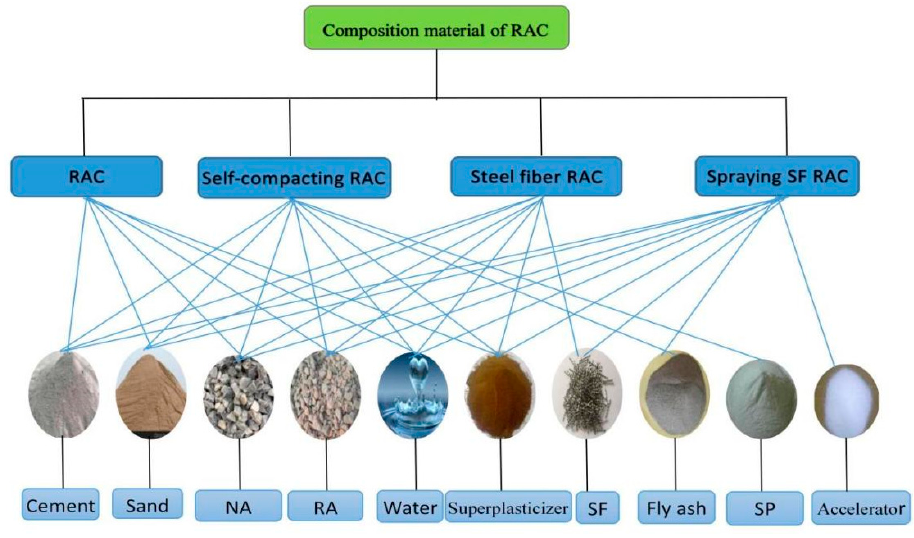
Figure 1. Composition materials of RAC. Table 1. Composition of the basic constituent materials, such as cement, and industrial residue.